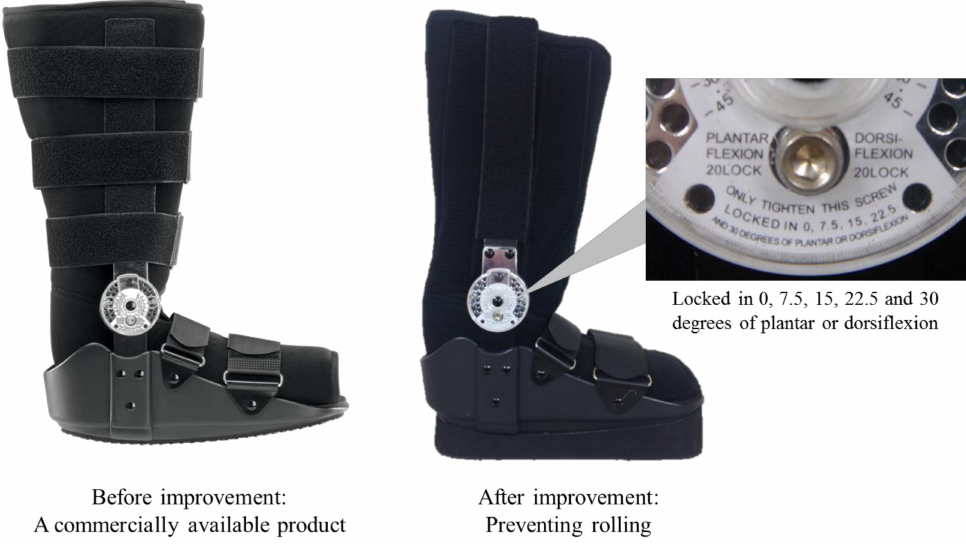
Figure 1. Restrict of ankle joint mobility by ankle foot orthosis. Dial-hinge-type walking brace for ankle mobility